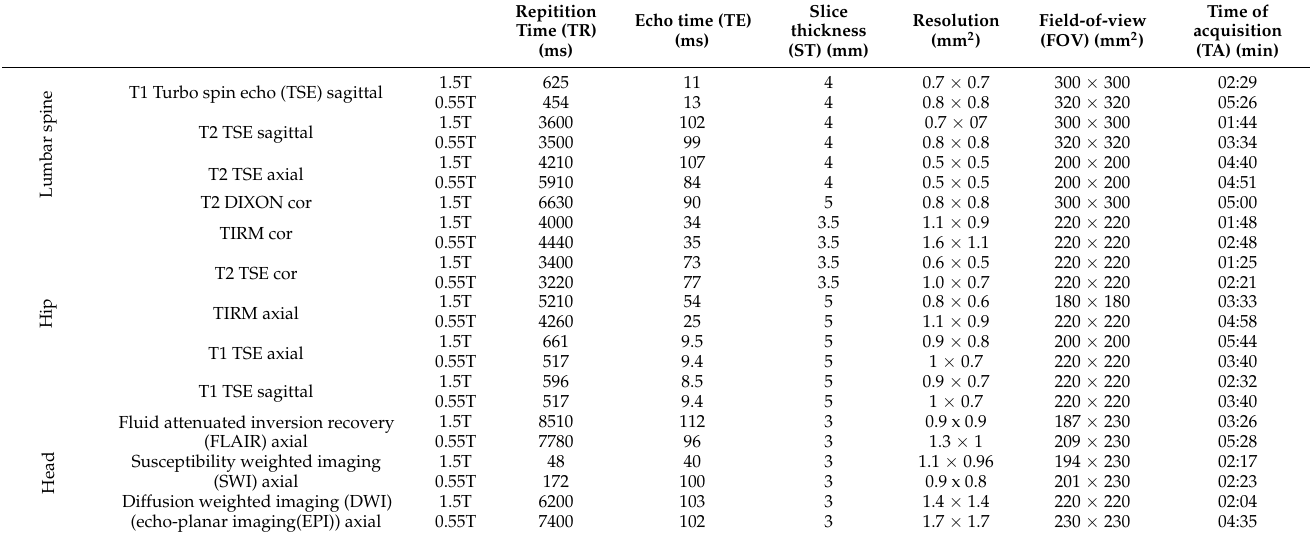
Table 2. Protocols for 0.55T and 1.5T for the three most imaged body regions (head, lumbar spine,